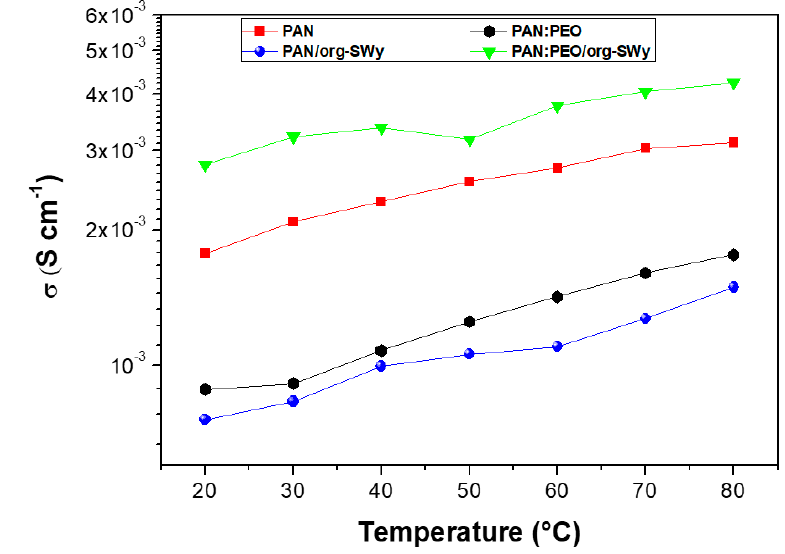
Figure 6. Temperature dependence of ionic conductivity for the gel polymer electrolytes investigated.